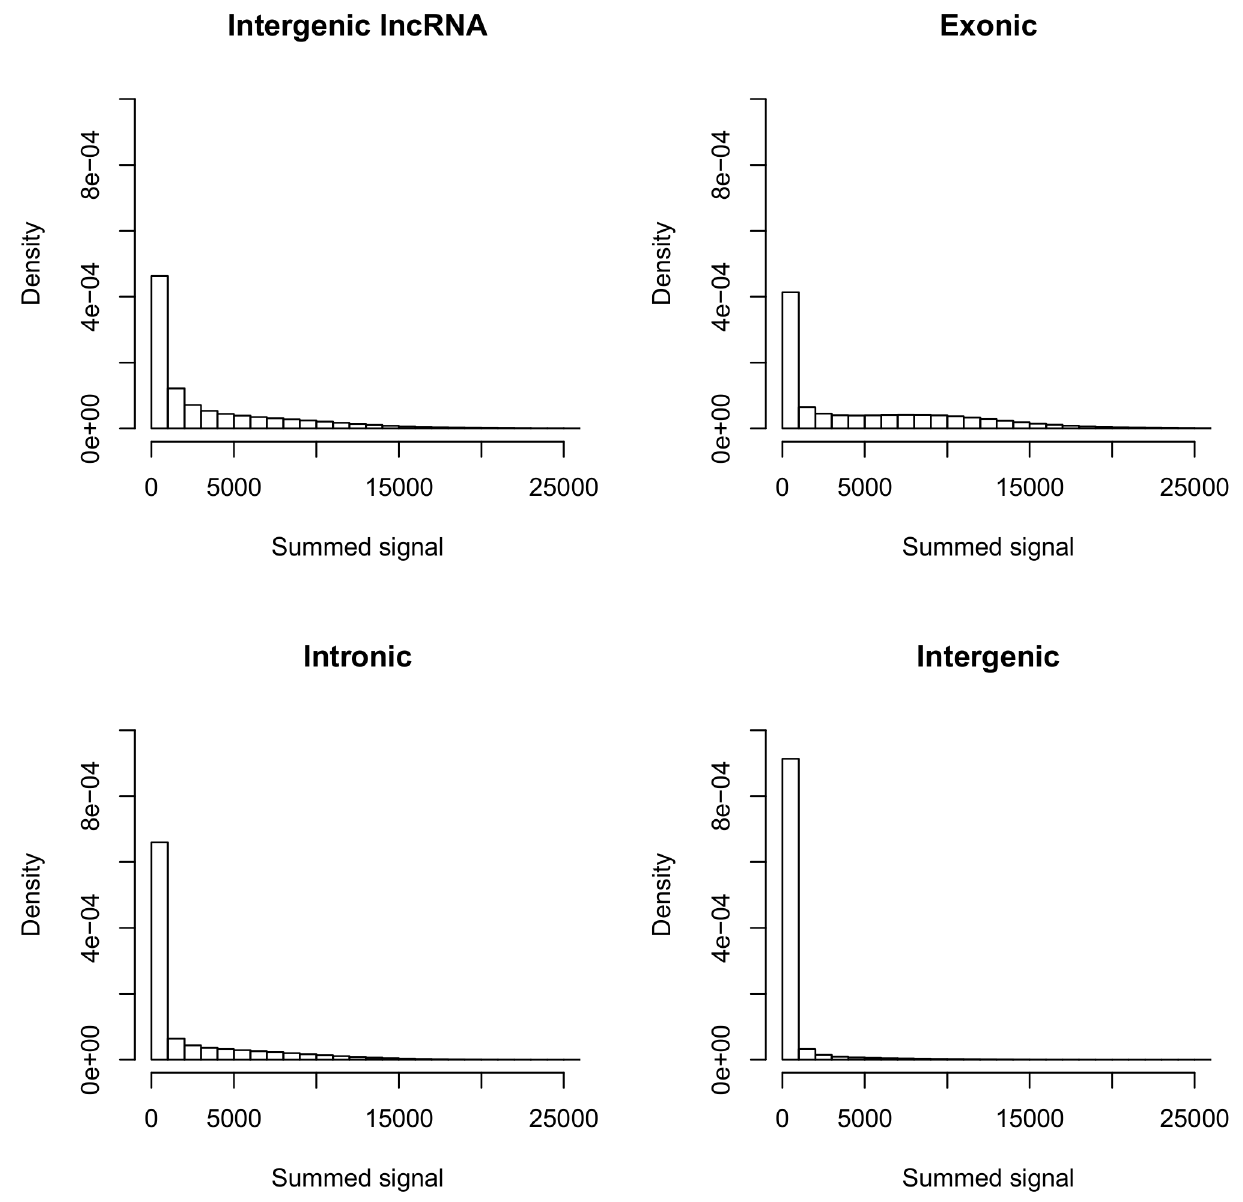
Figure 1. Comparison of total expression levels of regions annotated to intergenic lncRNAs, exons, introns, and intergenic regions. The horizontal axes in the panels show bins of fluorescence signals from the genotyping data, summed for both alleles to give a measure for total expression. The average expression levels of annotated transcripts were 4900 fluorescence units in exons, 2100 in introns, 590 in intergenic regions, compared to 3300 in the intergenic lncRNA regions that were used in the ASE analysis. The vertical axes show the number of observations in each bin.